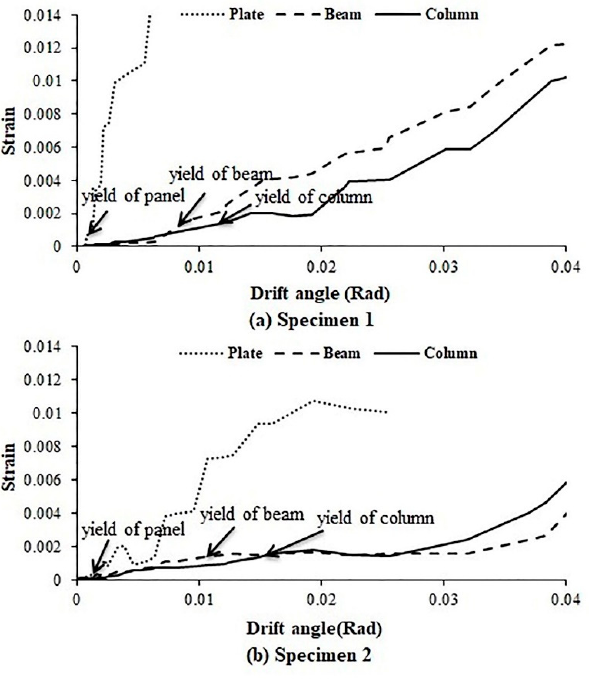
Figure 15. Inelastic behavior of the panel, beam and